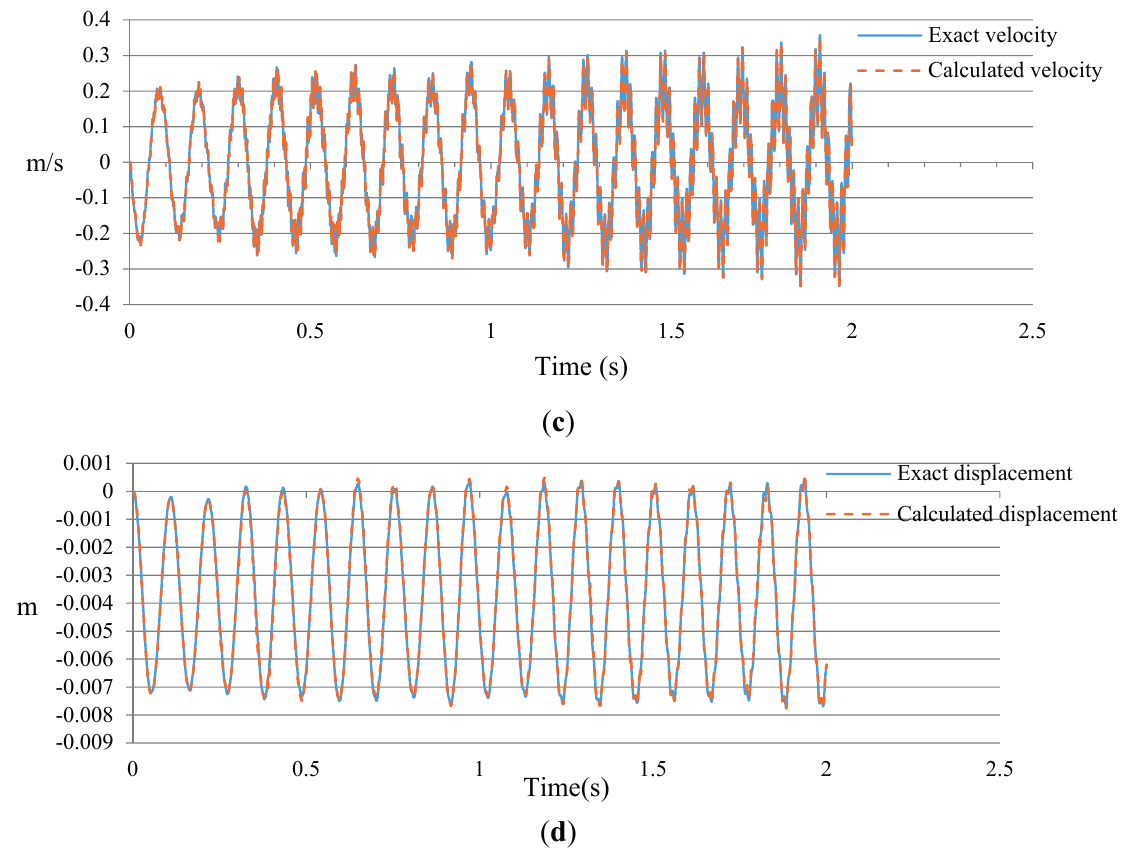
Figure 7. Input and response data at location 5 for undamaged case: ( a ) input force; ( b ) exact acceleration responses; ( c ) comparison of the exact velocity to the calculated velocity; ( d ) comparison of the exact displacement to the calculated